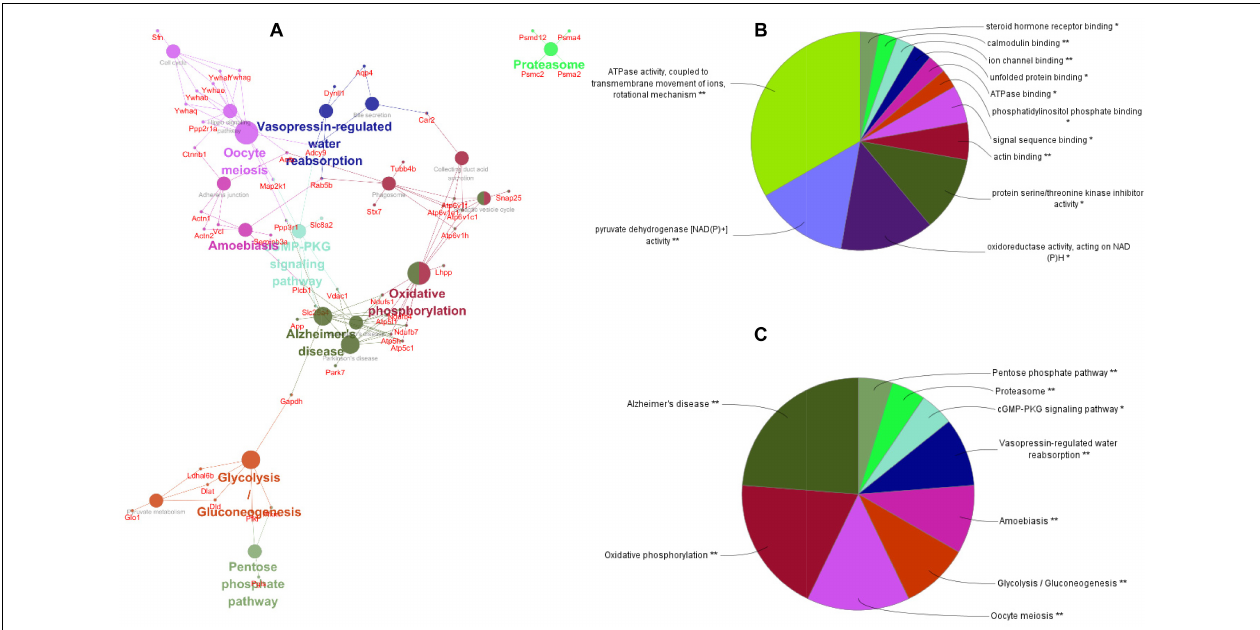
FIGURE 6 | The pathway network of the differentially expressed proteins (A) visualized using ClueGO software ( p ≤ 0.05, kappa ≥ 0.4); only the most significant interactions are shown. Network nodes represent pathways, and the sizes of the nodes reflect the enrichment significance of the GO terms. Edges represent connections between nodes. The color of the node represents the class it belongs to. Mixed coloring represents multiple classes. Ungrouped terms are not shown. Molecular function (B) and pathway enrichment (C) are determined by ClueGO ( p ≤ 0.05, kappa ≥ 0.4), and only the most significant terms are shown. * P < 0.05, ** P < 0.01.